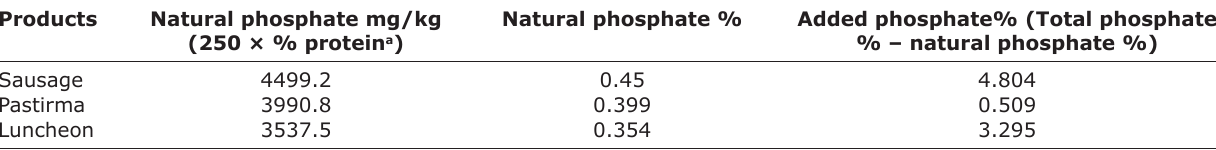
Table-4: The percentage of natural phosphate and the added phosphate in Egyptian processed meat. Products